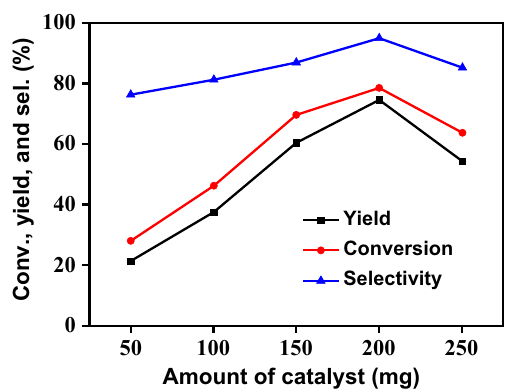
Fig. 2 Effect of the catalyst dosage. Reaction conditions: furfural 1 mmol, isopropanol 5 mL, reaction temperature 70 (cid:3) C, reaction time